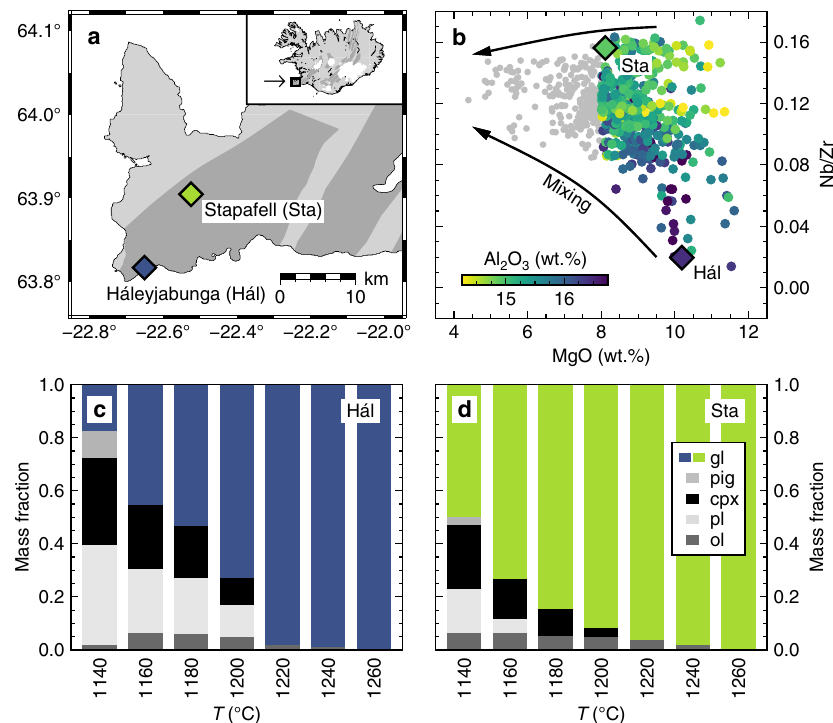
Fig. 1 Mantle-derived chemical variability in Icelandic basalts and its effects on the phase equilibria of primitive magmas. a Locations of the incompatible element-depleted Háleyjabunga (Hál) and incompatible element-enriched Stapafell (Sta) lavas on the Reykjanes Peninsula of southwest Iceland. Volcanic systems are highlighted in dark grey. This map (and all subsequent plots) were produced with The Generic Mapping Tools (GMT) 6 80 . b Summary of major and trace element variability in lavas from southwest Iceland 42 . MgO re fl ects the degree of magmatic evolution and Nb/Zr the degree of mantle-derived incompatible element enrichment. At any given MgO content, incompatible element-enriched lavas like those from Stapafell have lower Al 2 O 3 contents than incompatible-element depleted lavas like those from Háleyjabunga. Arrows illustrate the reduction in chemical variability that results from concurrent mixing and crystallisation during magmatic evolution 8,9 . c , d Phase equilibria of Háleyjabunga ( c ) and Stapafell ( d ) lava analogues derived from crystallisation experiments at 300 MPa 7 . Equilibrium phase assemblages and proportions are related to the degree of incompatible element enrichment: plagioclase crystallises at higher temperatures and in greater amounts from incompatible element-depleted magmas that are correspondingly enriched in refractory elements like CaO and Al 2 O 3 . Phases are labelled as follows: gl glass, pig pigeonite, cpx clinopyroxene, pl plagioclase, ol